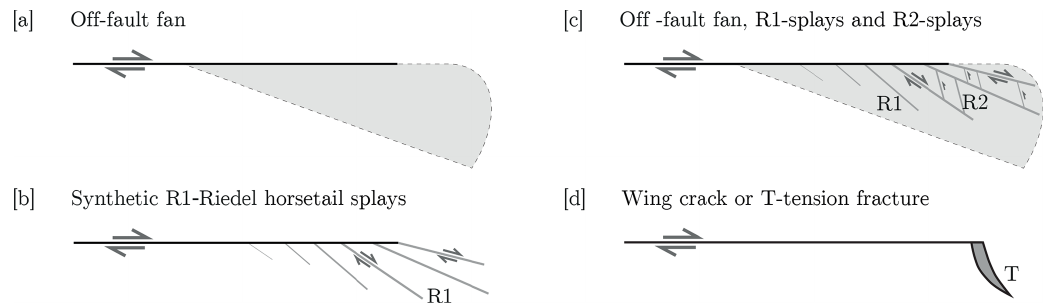
Figure 1. Fault structures developing at the tip of a sliding strike-slip fault. Modified from Kim et al. (2004) and combined with schematic interpretations from Faulkner et al. (2011) and Perrin et al. (2016b). R1 is the synthetic Riedel shear fracture, R2 is the antithetic conjugate Riedel shear fracture, and T is the tension fracture or wing